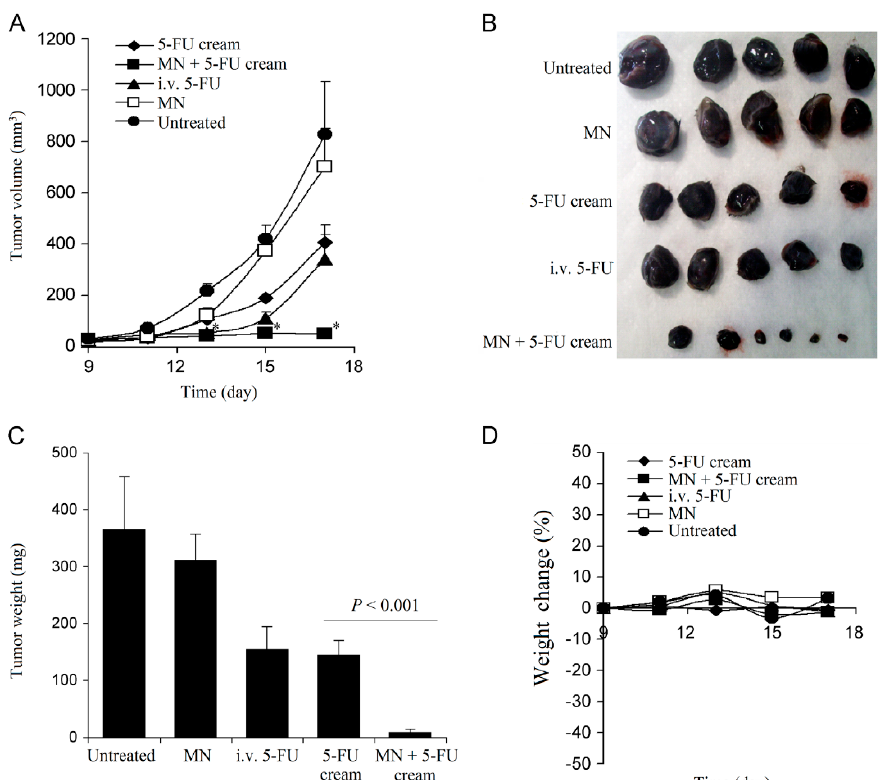
Figure 10. ( A ) The growth curves of B16-F10 tumors in mice. The asterisks (*) in ( A ) indicates that the values of the 5-FU cream group and the MN + 5-FU cream group are different on day 13, 15, and 17 ( P < 0.05). ( B ) Digital photographs of tumors at the end of the study. ( C ) The weights of tumors at the end of the study. ( D ) The changes in the body weight of B16-F10 mice, reproduced with permission from [256], Elsevier, 2013.